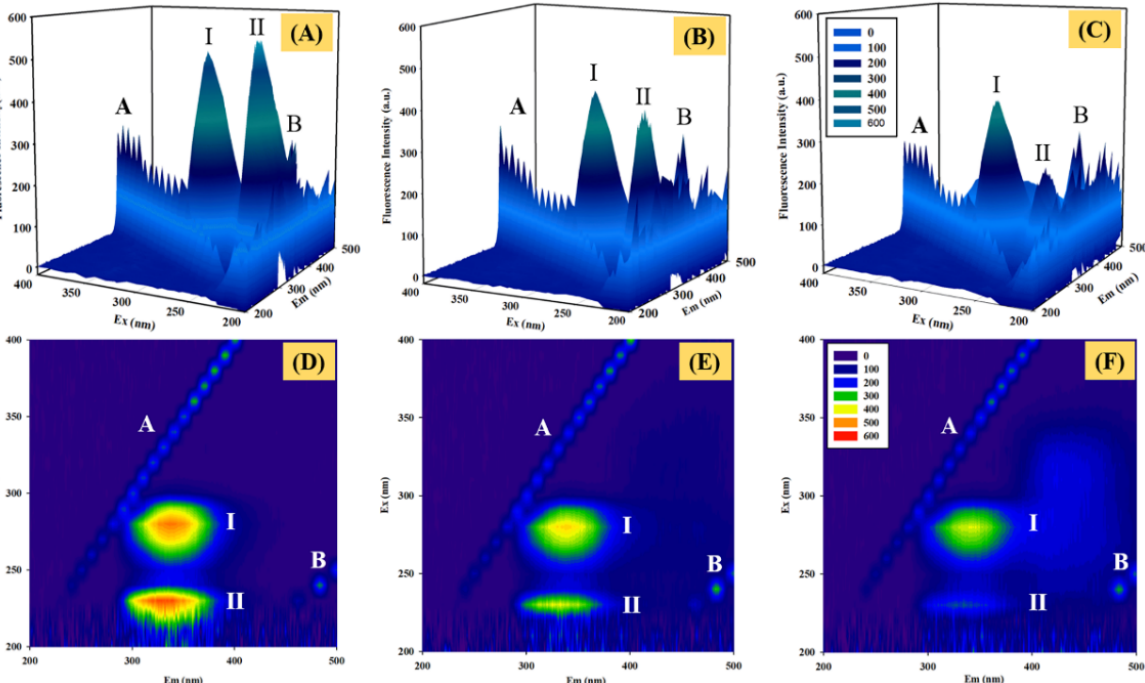
Figure 9. The 3D fluorescence spectra of free HSA ( A ) and HSA–GDC-0941 solution in the molar ratio of 1:1 ( B ) and 1:3 ( C ). Contour plots of 3D fluorescence spectra of free HSA ( D ) and HSA–GDC-0941 solution in the molar ratio of 1:1 ( E ) and 1:3 ( F ).